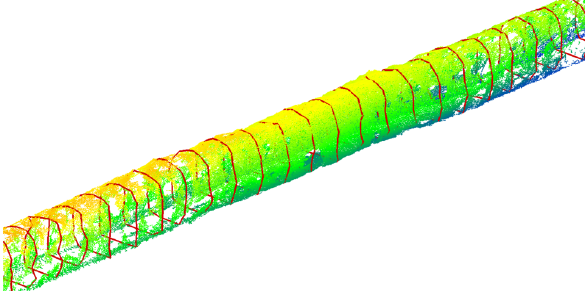
Figure 5. The extracted tunnel cross-sections overlaid on the point clouds. Only the first one of each five successive cross-sections is shown (i.e., 2.5 m interval).